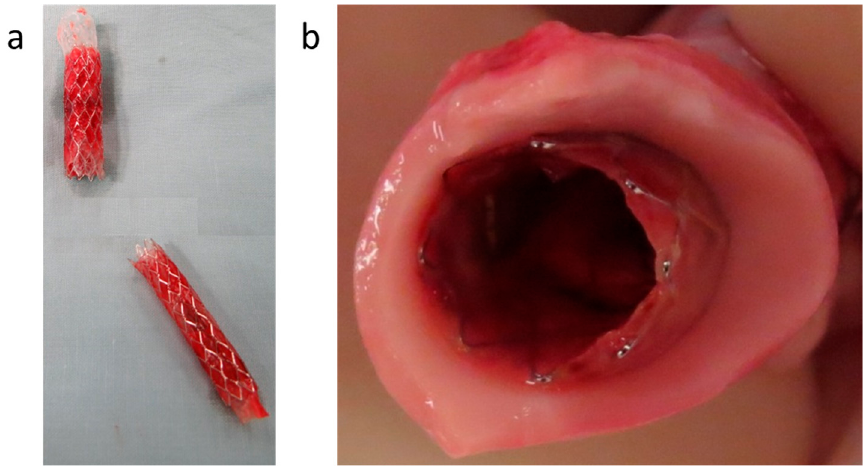
Figure 12. ( a ) Two explanted devices (upper device is 12 mm diameter and lower right is 7 mm diameter); ( b ) Explanted aorta with the implanted device after two weeks survival.